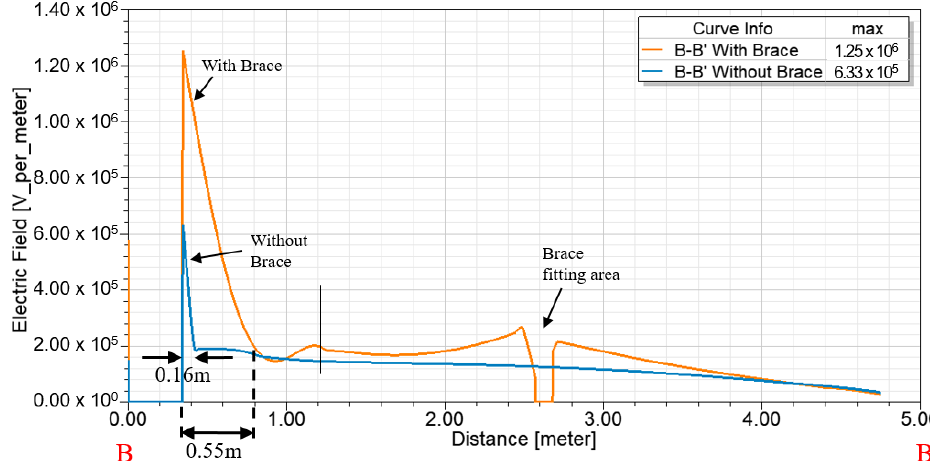
Figure 14. Localized E-Field near to end-fittings of the alternate tie member (B –B’ ).